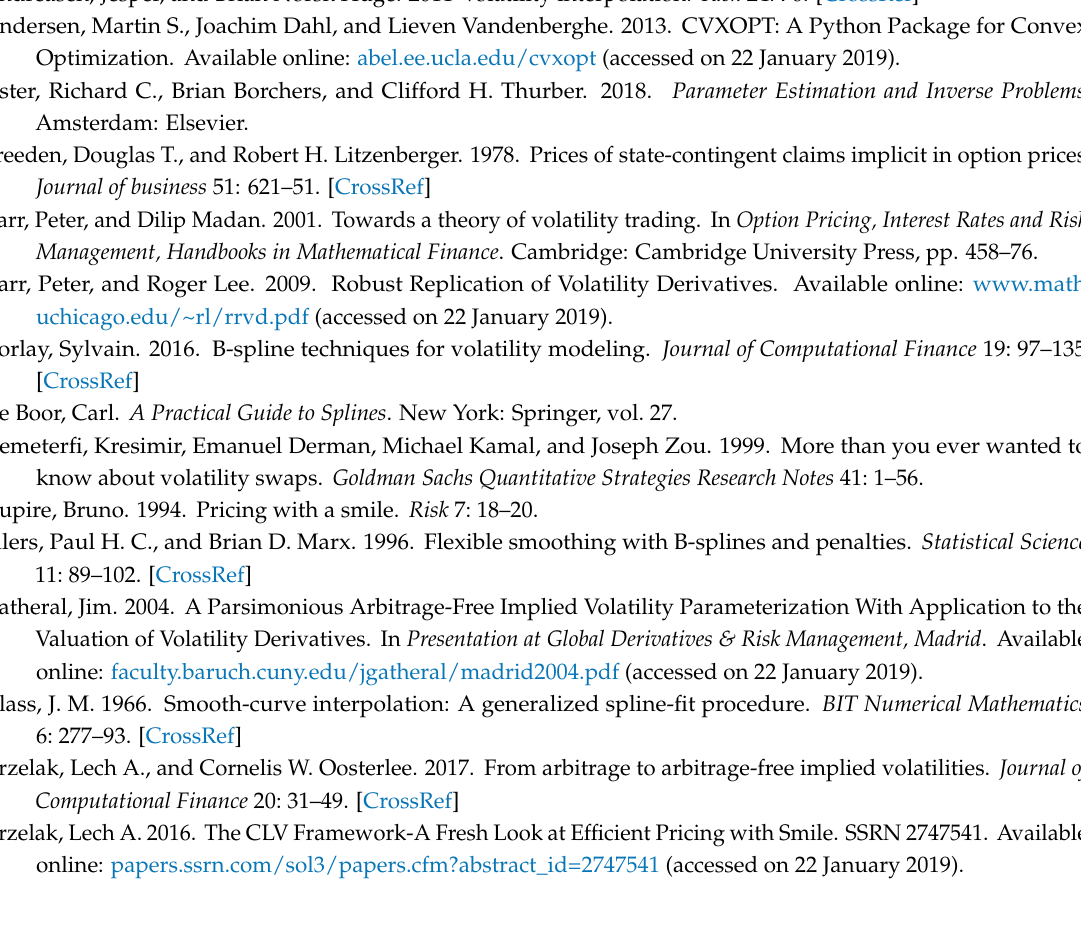
for an option of maturity T = 5.0722, corresponding F